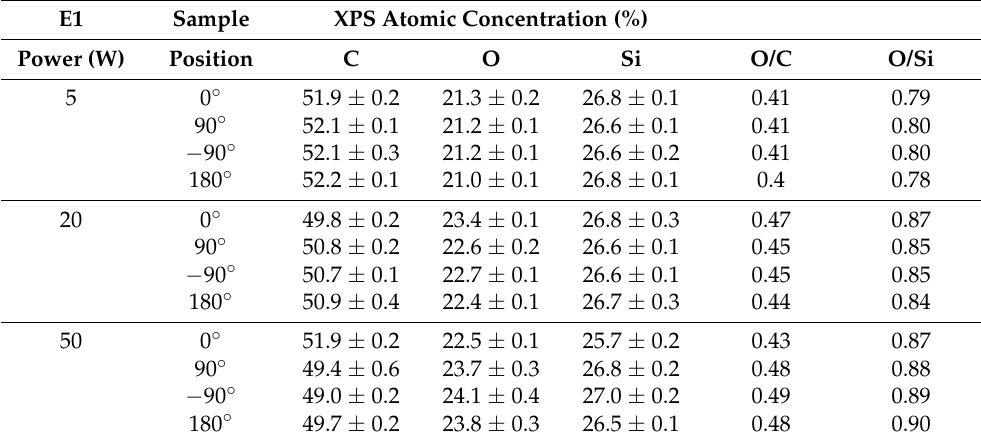
Table 2. XPS atomic concentrations and O/C and O/Si ratios for RF TMDSO films deposited at various powers.